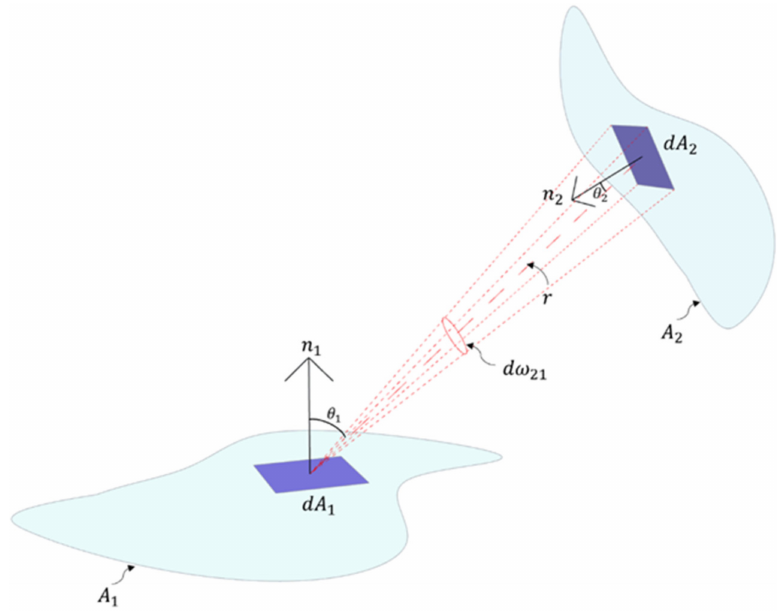
Figure 1. The geometry and variables for calculating view factor between two surfaces A 1 and A 2 .